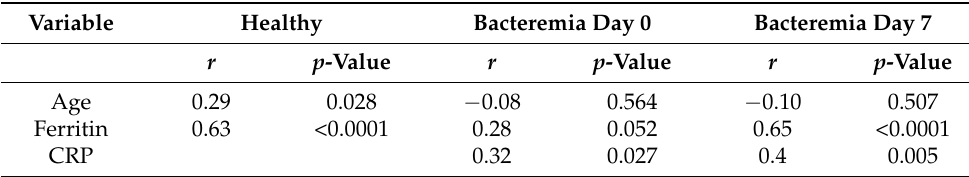
Table 4. Correlation of hepcidin levels with other variables in healthy controls and bacteremia patients on day 0 and day